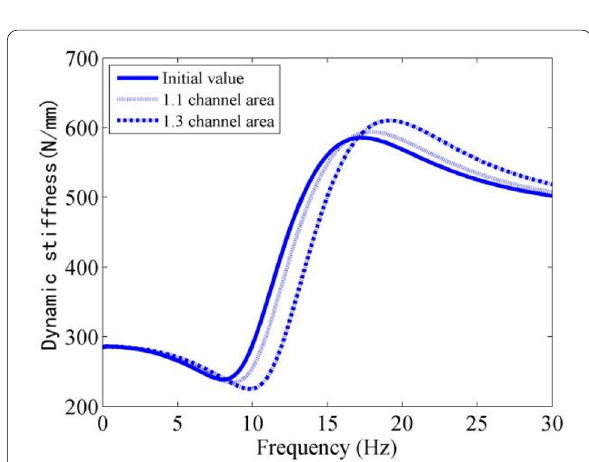
Figure 12 Dynamic stiffness vs. frequency curves in different inertial channel areas